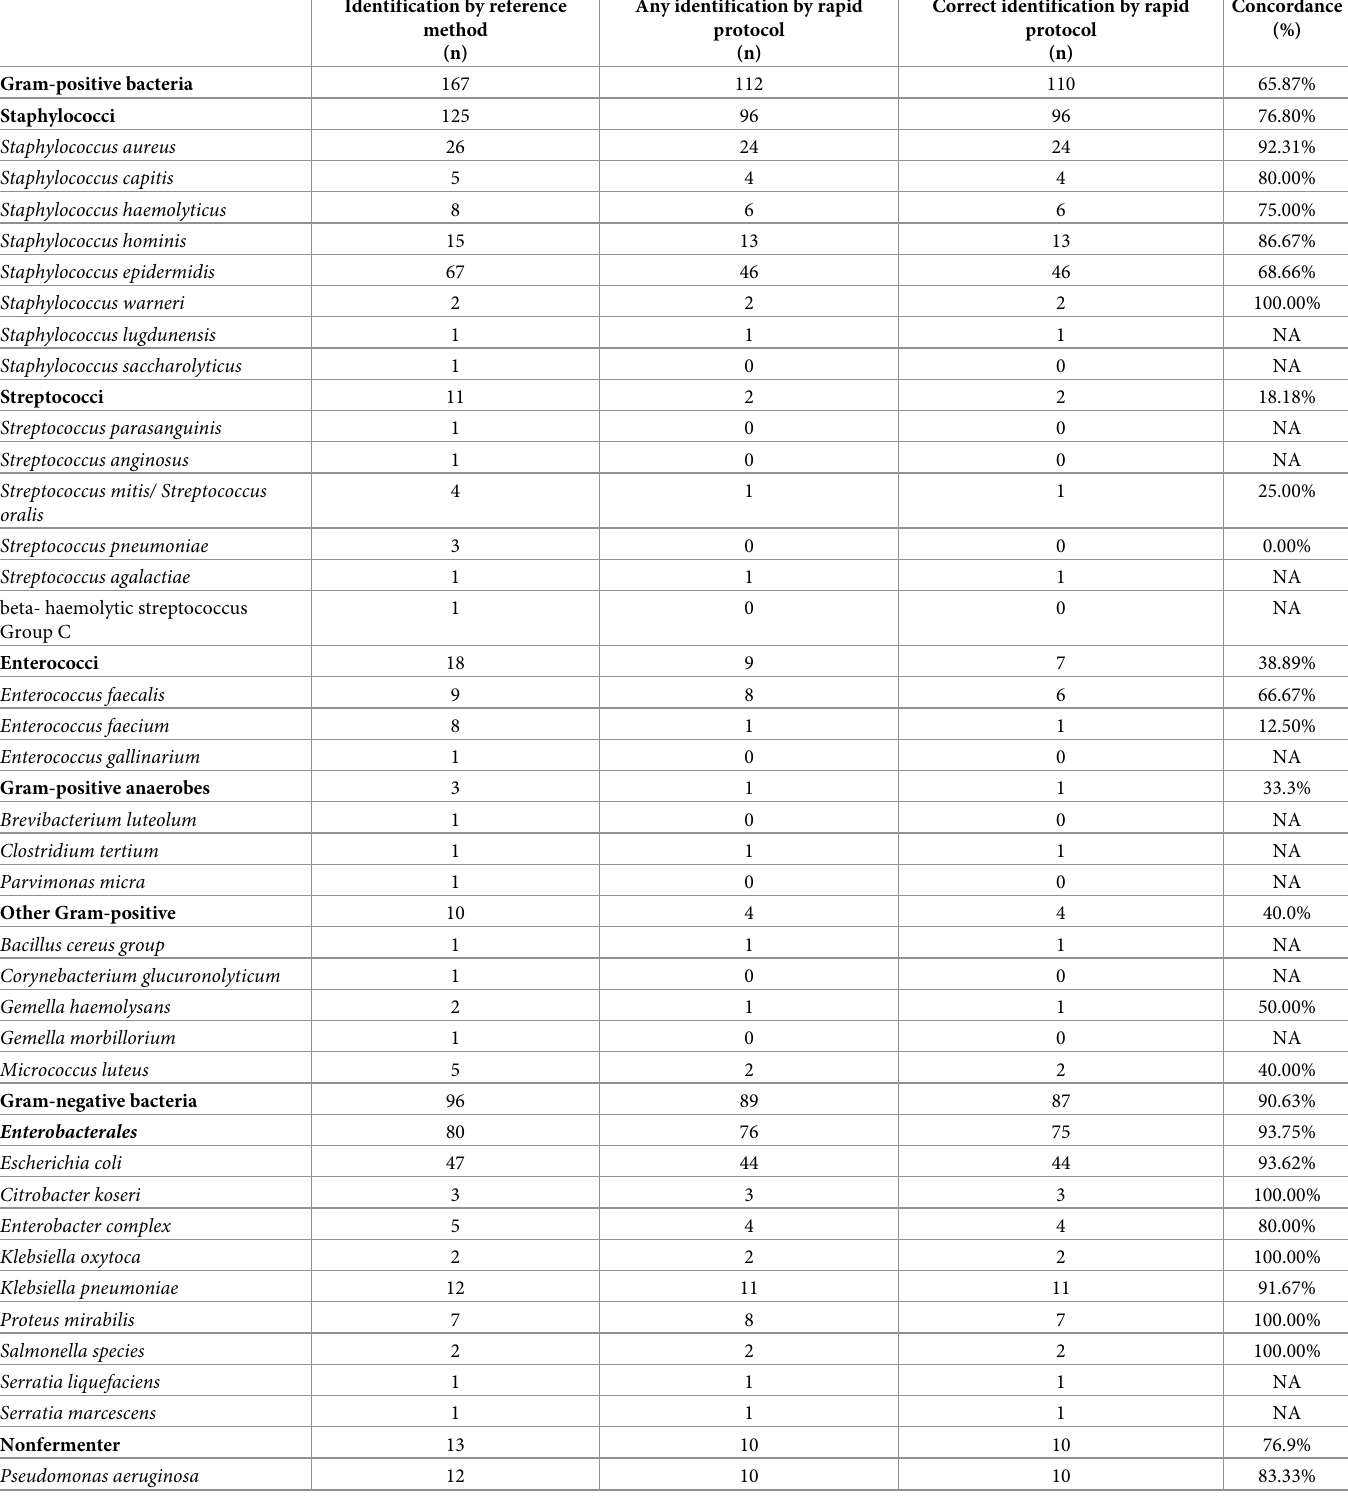
Table 1. Sensitivity and concordance of the in-house protocol on clinical samples by